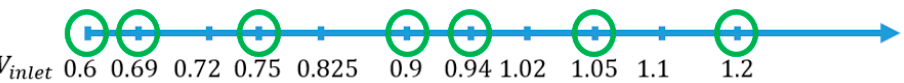
Figure 25. RMSE distribution over time, when four pairs of data are used for training.